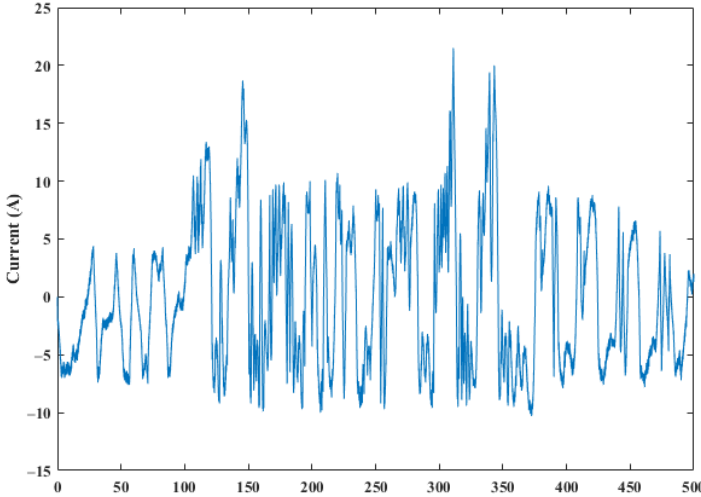
Figure 14. EPS motor current detection values when driving on flat terrain.